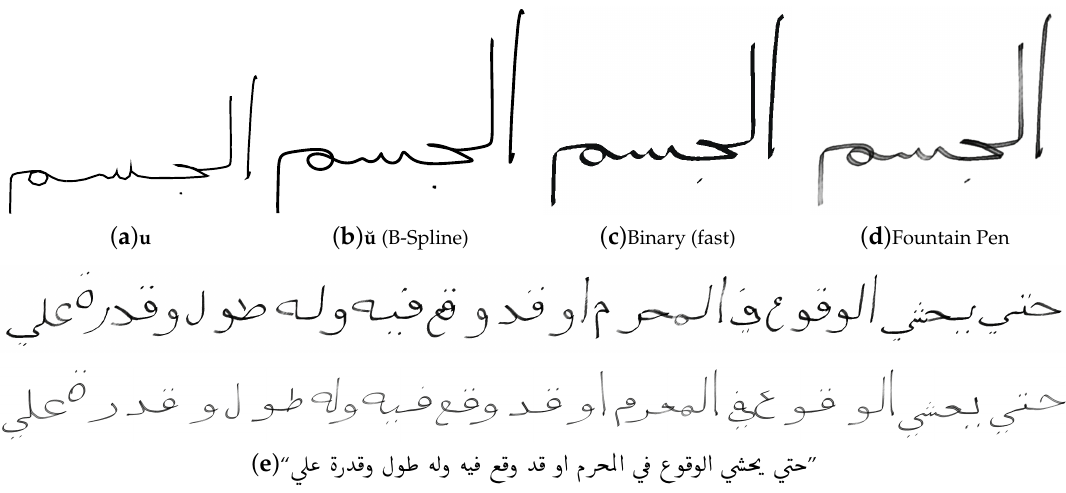
Figure 4. From the Polygon u to a synthetic image that simulates a feather like writing instrument. ( a–d ) Visualization of the used methods. ( e ) Two syntheses of an Arabic Unicode text line demonstrate the